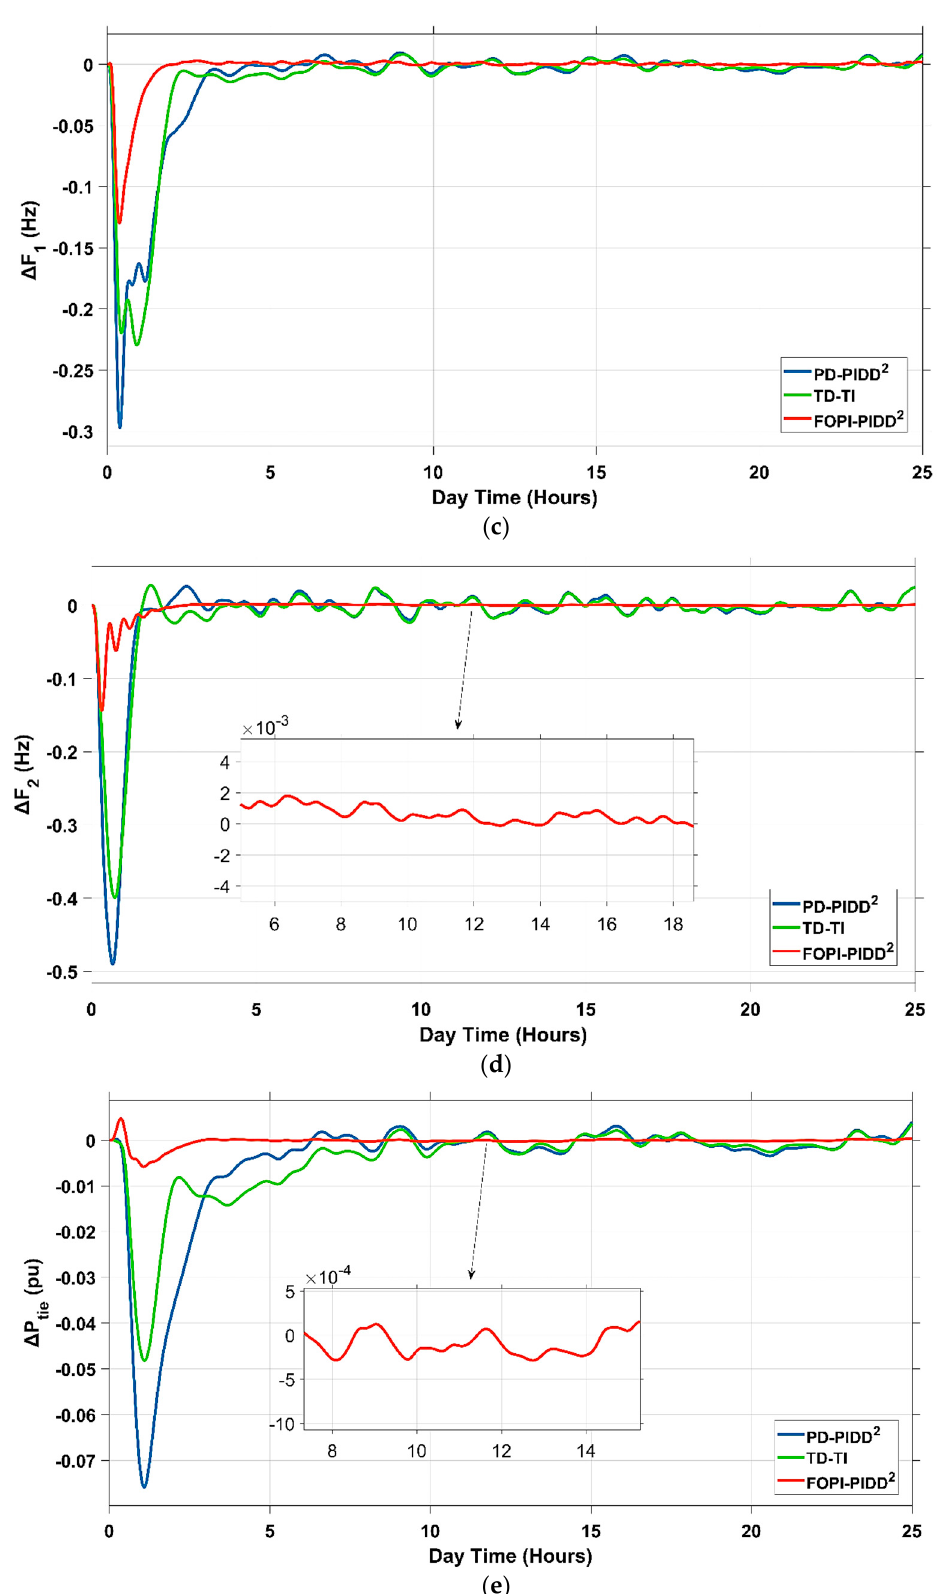
Figure 26. Comparison of PD–PIDD 2 , TD–TI, and FOPI–PIDD 2 optimized by DO algorithm for scenario 4: ( a ) V 1 , ( b ) V 2 , ( c ) Δ F 1 , ( d ) Δ F 2 , and ( e ) Δ P tie .